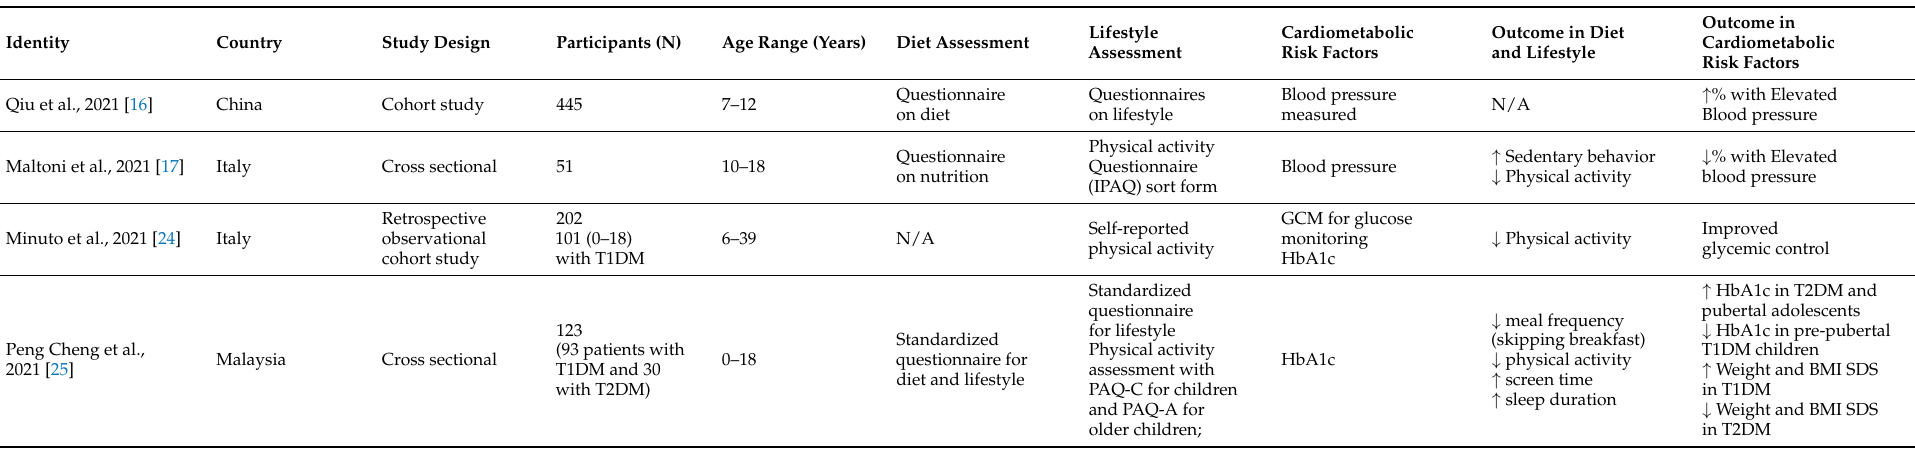
Table 2. Study characteristics regarding the role of diet and lifestyle changes on cardiometabolic